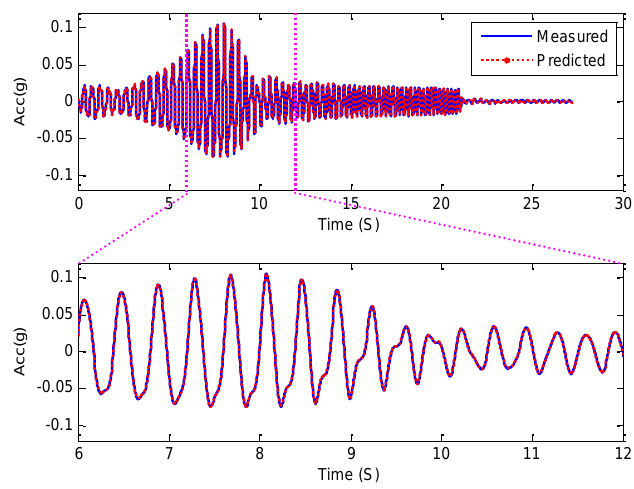
Figure 7. Nonlinear AutoRegresive with eXogenous inputs (NARX) identification model 8 for the acceleration response.